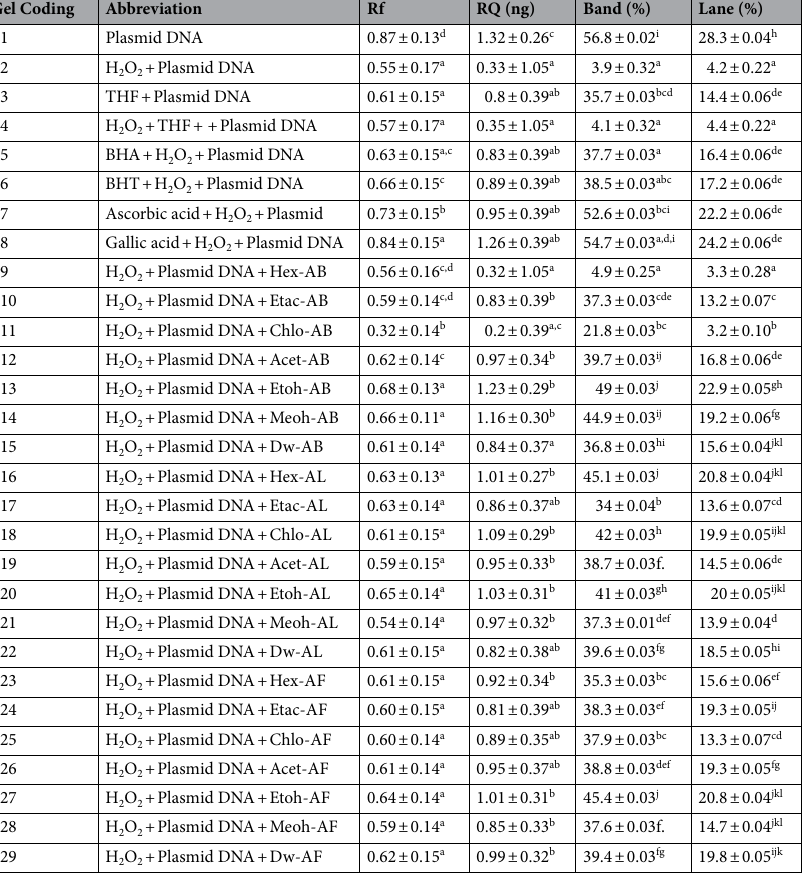
Table 2. Densiometric analysis of gel image of DNA nicking inhibition by solvent extracts of T